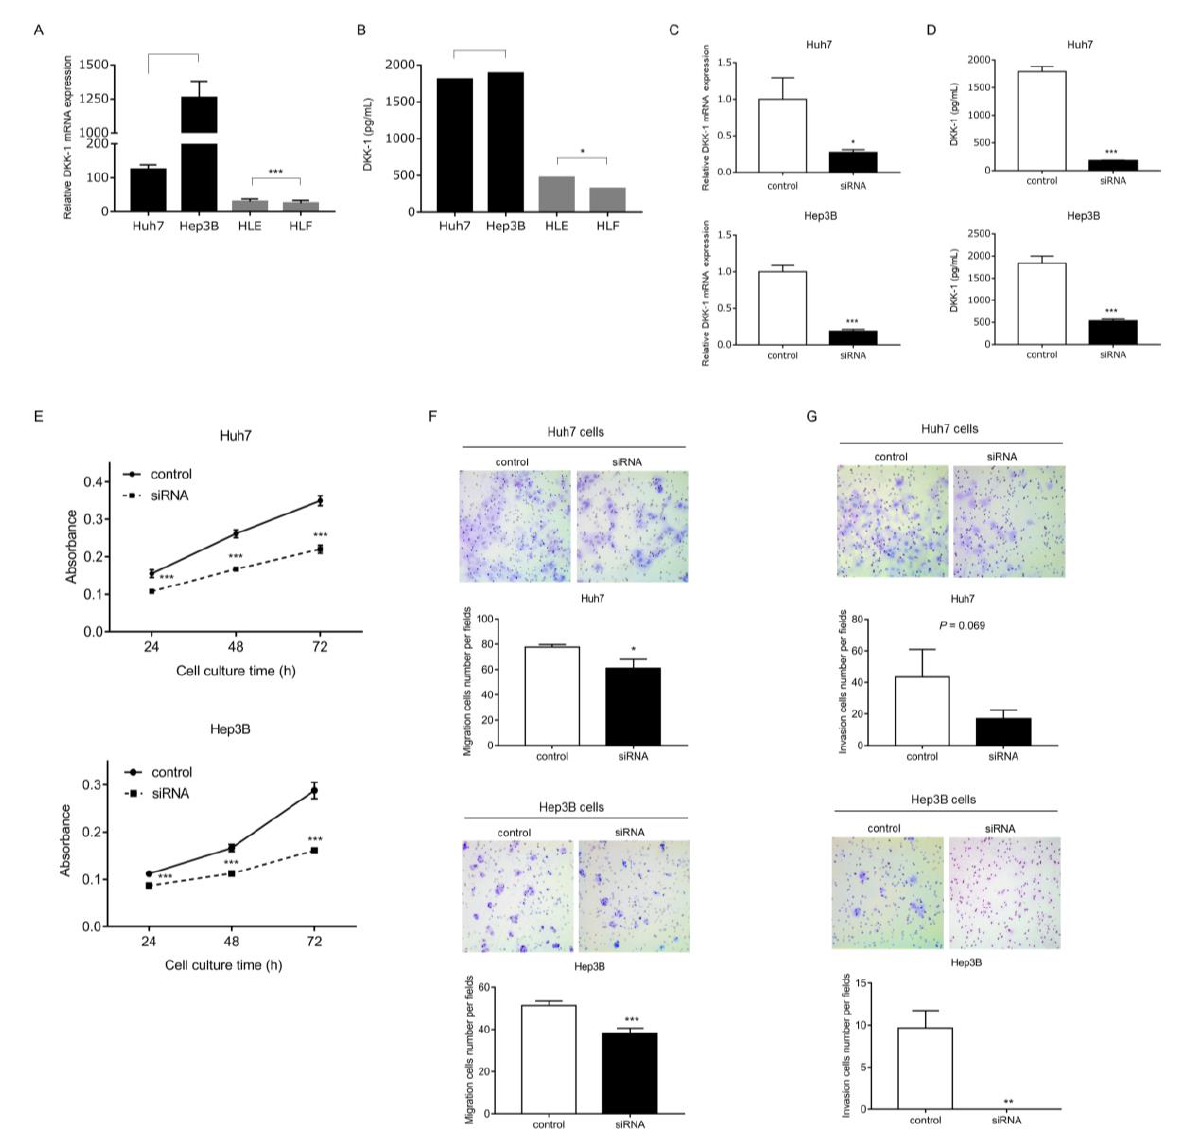
Figure 6. mRNA and protein expression of DKK-1 in HCC cell lines and in Huh7 and Hep3B cells knocked down for DKK-1 using siRNA. ( A ) DKK-1 mRNA expression was higher in Huh7 and Hep3B cells than in HLE and HLF cells ( p < 0.001). ( B ) DKK-1 protein levels in the culture supernatant were significantly higher in Huh7 and Hep3B cells than in HLE and HLF cells ( p < 0.05), as evaluated using ELISA. ( C ) DKK1 mRNA levels were significantly decreased in Huh7 and Hep3B cells following siRNA transfection (* p = 0.013 and *** p < 0.001, respectively; n = 3 for each group). ( D ) DKK-1 protein levels in the culture supernatant were also significantly decreased in Huh7 and Hep3B cells following siRNA transfection ( p < 0.001; n =4 for each group). Proliferation, migration, and invasion in Huh7 and Hep3B cells. ( E ) The proliferation of Huh7 and Hep3B cells was significantly suppressed by DKK-1 knockdown at 24, 48, and 72 h ( p < 0.001 at 24, 48, and 72 h; n = 6 for each group. ( F ) Migration capacity was attenuated by DKK-1 knockdown in Huh7 and Hep3B cells with statistical or borderline significance ( p = 0.017 and p < 0.001, respectively; n =3 for each group). ( G ) Invasion capacity was attenuated by DKK-1 knockdown in Huh7 and Hep3B cells with borderline statistical significance (** p = 0.069 and p < 0.001, respectively; n =3 for each group). We knocked down DKK-1 using small interfering RNA (siRNA) in Huh7 and Hep3B cells, and the effect was confirmed at the mRNA and protein levels ( p < 0.001; Figure 6C,